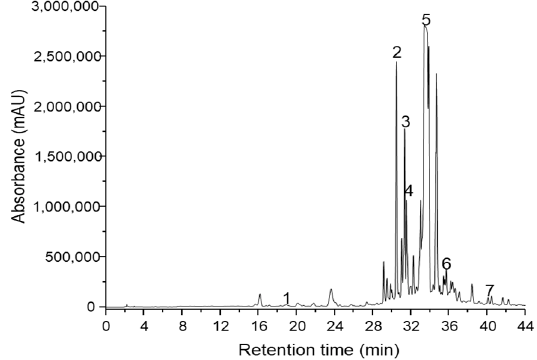
Figure 2. Chromatogram of identified polyphenolic compounds detected in extracts of Origanum vulgare ( 1-p-OH-benzoic acid; 2-vitexin 2-O-rhamnoside; 3-sinapic acid; 4-isoquercitrin; 5-rosmarinic acid; 6-resveratrol; 7-apigenin).